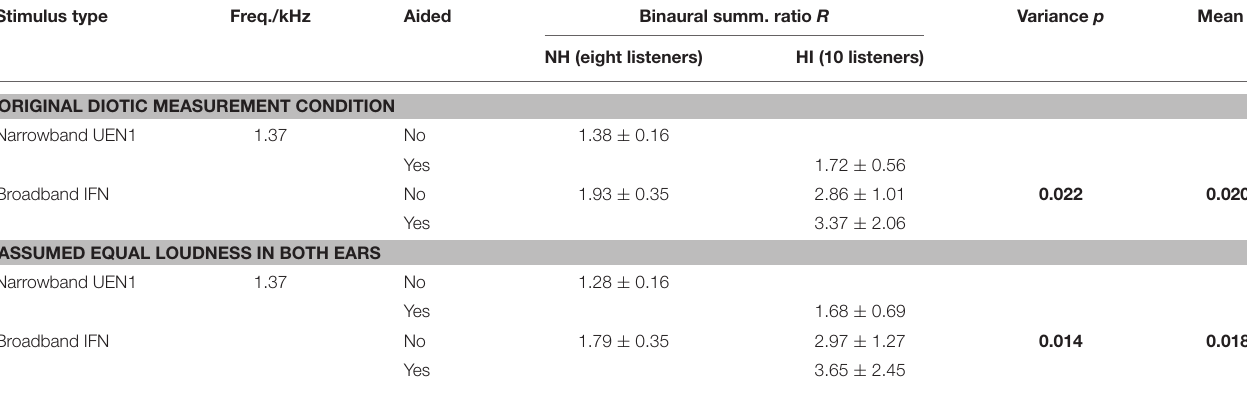
TABLE 2 | Binaural summation ratios averaged across listeners of Dataset